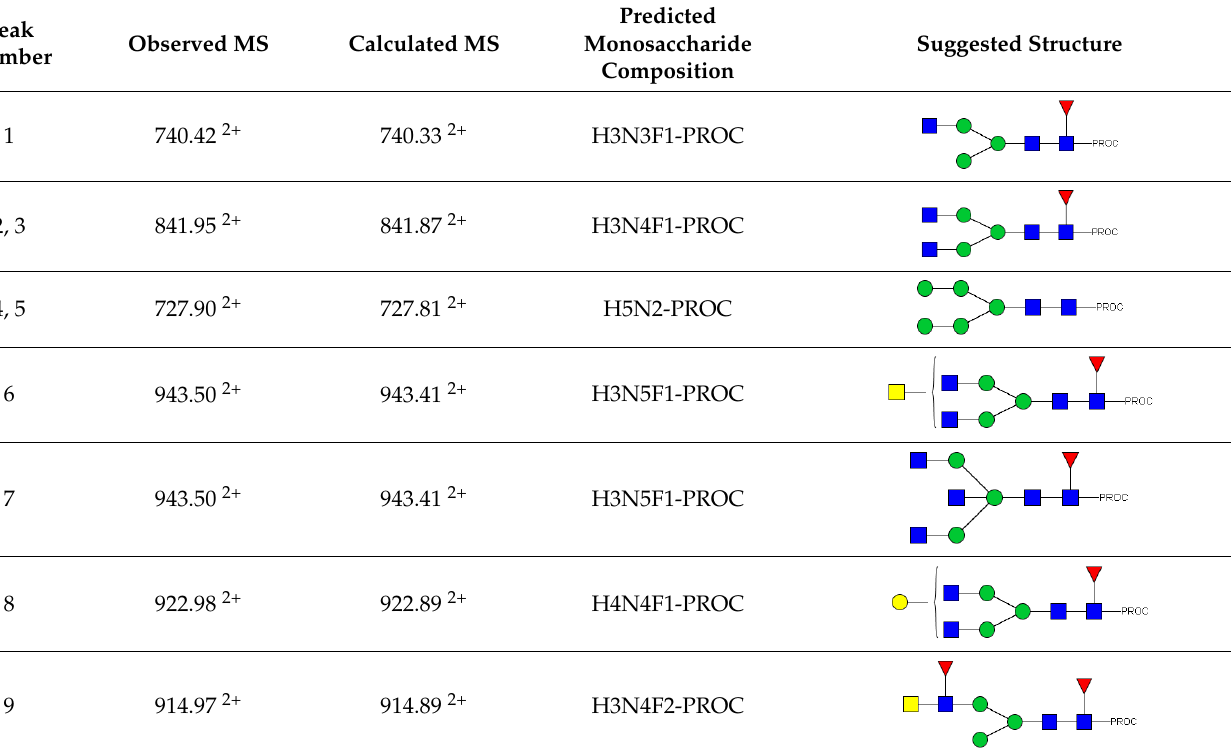
Table 2. Predicted Monosaccharide Compositions and Suggested Glycan Structures for Neu-IgE based on observed MS m/z masses. Numbered peaks are shown in Figure 3. H = Hexose; N = N- Acetylhexosamine; F = Fucose; S = Sialic Acid.